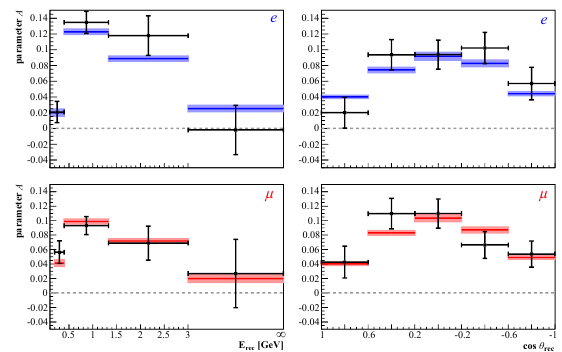
Figure 6. The parameter, A , depending on the reconstructed en- ergy (left) and zenith angle (right), for e -like (upper) and µ -like (lower) events, from the Super-K data (points with statistical er- ror) and MC simulations (boxes with systematic error). A grey dotted line is drawn at A = 0, the case of no east-west asymme- try, as a visual guide. The highest energy bin in the left plots is unbounded from above.